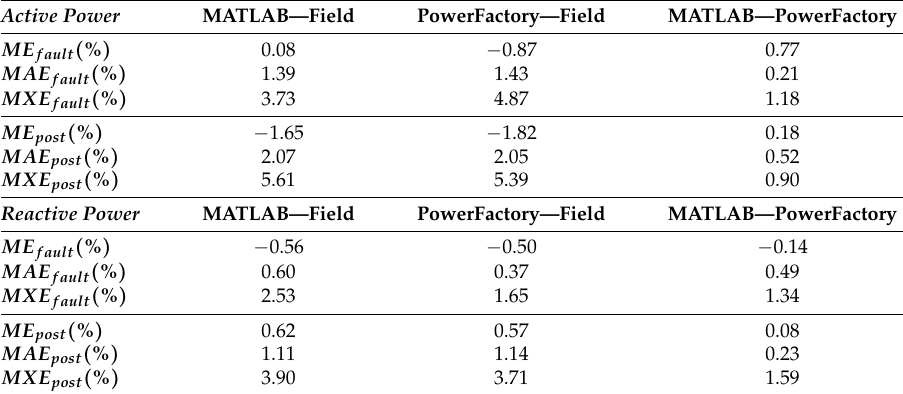
Table 4. Validation errors of Test Case 2: u = 0.25 pu, t = 625